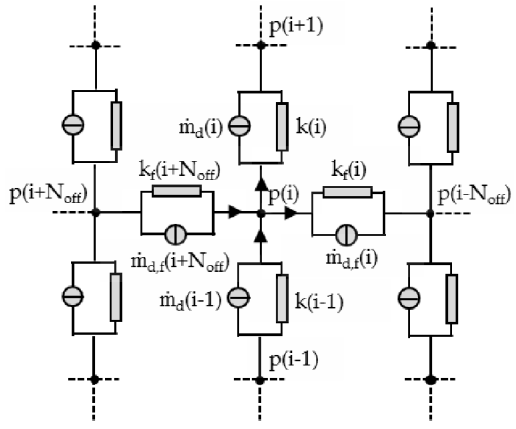
Figure 9. Equivalent circuit